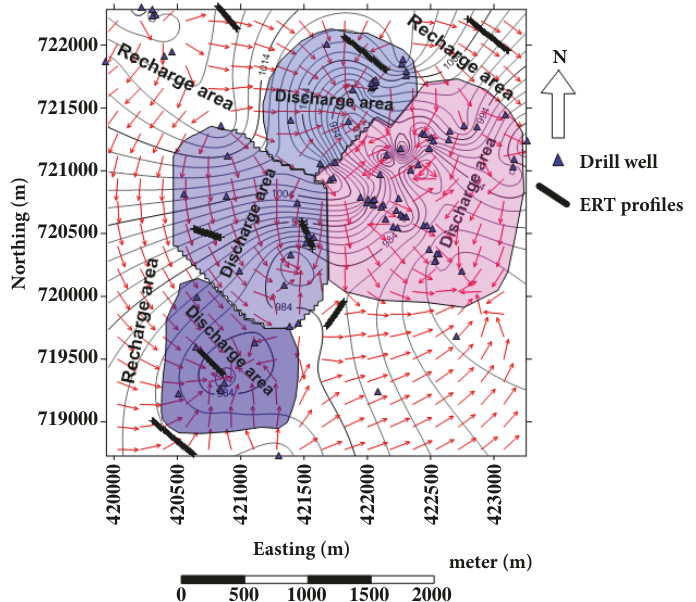
Figure 22: Groundwater vector map of the study